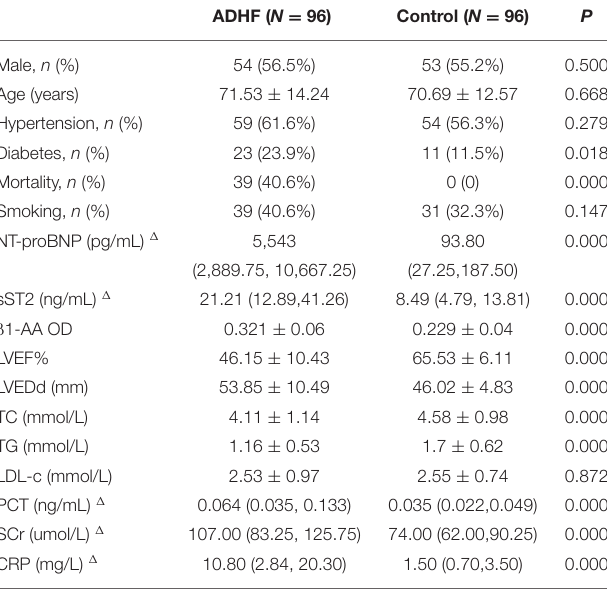
TABLE 1 | Baseline characteristics of